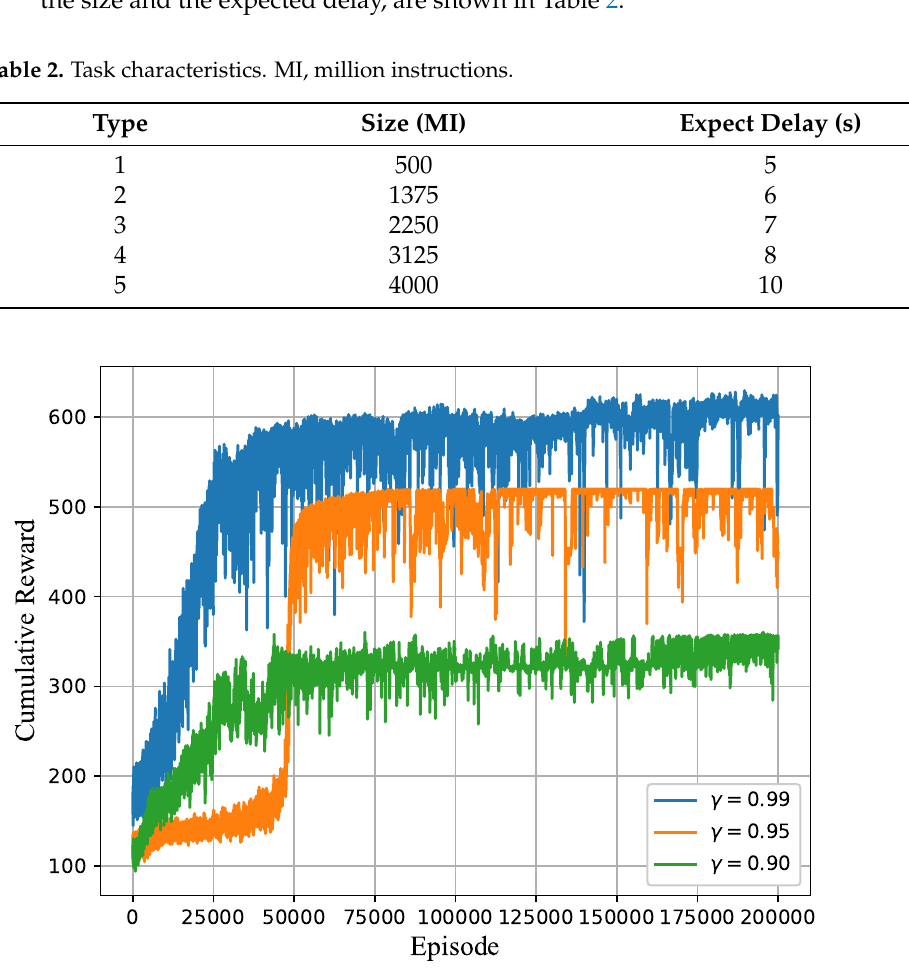
Figure 5. Cumulative reward per